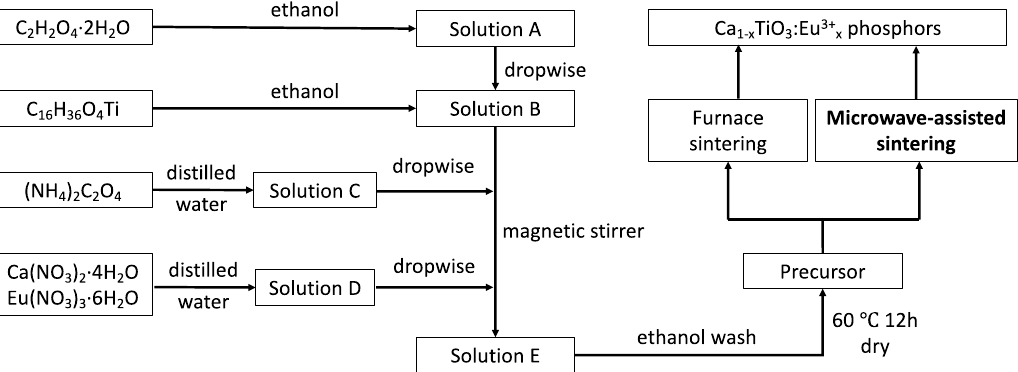
Figure 1. Flow chart of the experimental process for synthesizing the Ca 1-x TiO 3 :Eu 3+x phosphors.